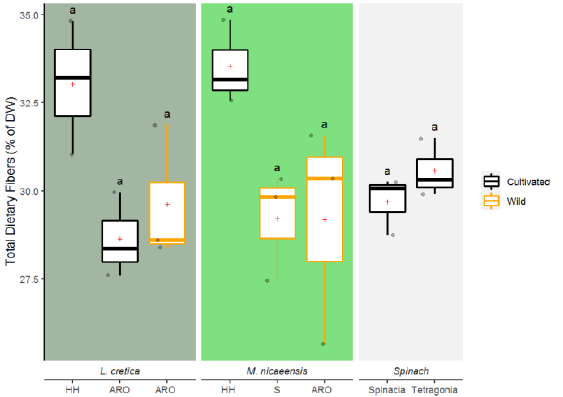
Figure 7. Total dietary fiber content in leaves of two Malvaceae species and two spinach species. Different lowercase letters indicate significant differences between populations of green leaves ( p < 0.05). Species names and abbreviations of locations are given in the lower line. HH = Havat Hanoi, ARO = research site at the Agricultural Research Organization; S = agricultural area near Sandala village, North Israel. Box plot color indicates “Cultivated” in an agricultural field, or “Wild”, grown wildly at field margins or feral fields. Median and average are indicated as a horizontal line within the box plot and red cross respectively, and gray dots denote results of single analyses.